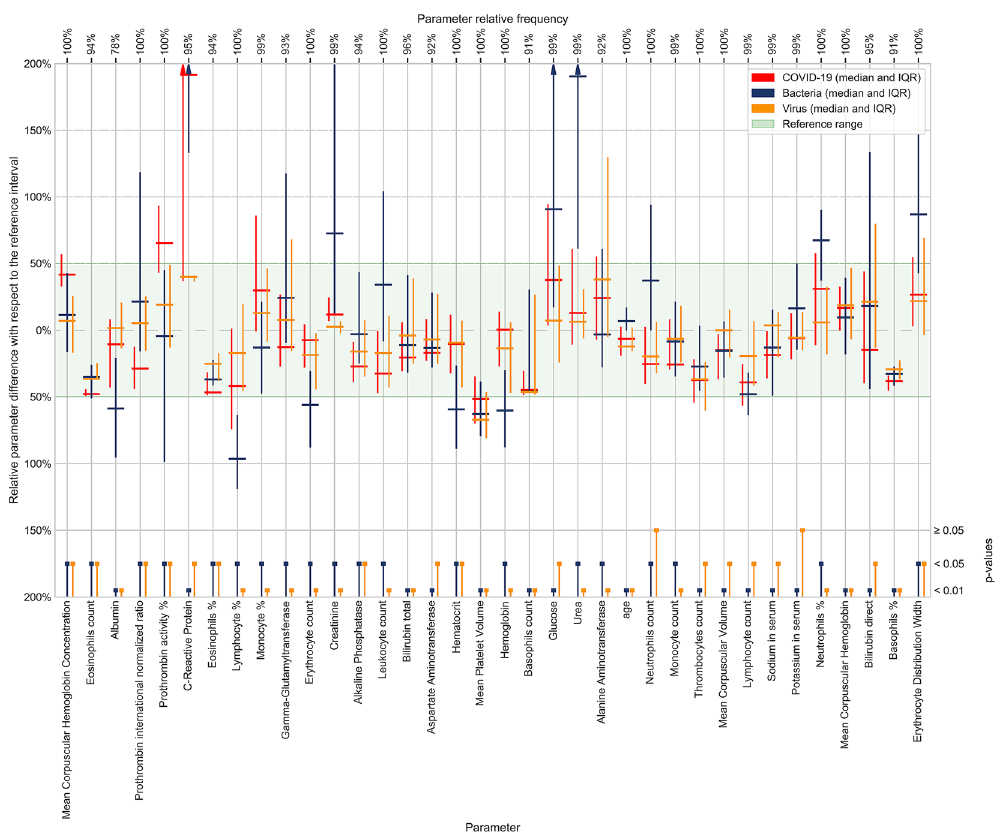
Figure 2. Blood parameters sorted by their XGBoost importance score. More important parameters are shown on the left. Group median values and IQR of the blood parameters used in model building are shown, centered, and scaled to reference intervals. Median bar for the C-reactive protein in bacterial infections is out of the scale at 38 mg/L. Groups (COVID-19/other virus/bacteria) were evaluated by the Anderson–Darling test. The significance levels (0.05 or 0.01) of the test results are depicted at the bottom of the figure.